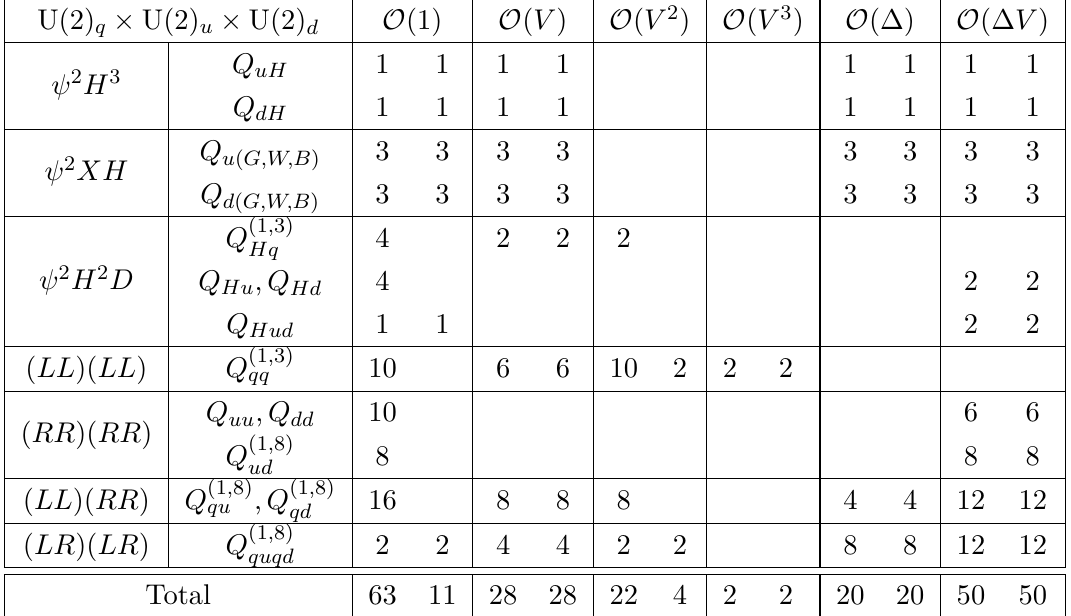
Table 2 . Counting of the pure quark SMEFT operators (see appendix A) assuming U(2) q × U(2) u × U(2) d symmetry in the quark sector. The counting is performed taking up to three insertions of the V q spurion, one insertion of ∆ u,d and one insertion of the ∆ u,d V q spurion product. The left (right) entry in each column gives the number of CP even (odd) coefficients at the given order in spurion